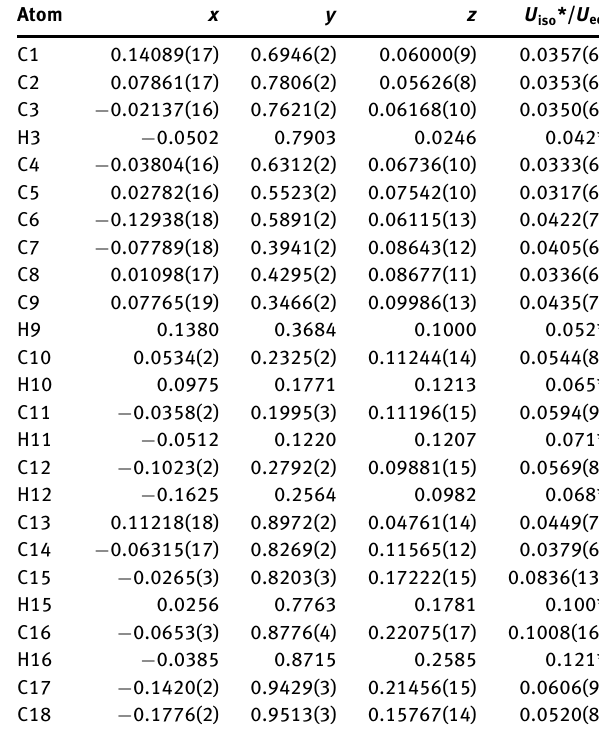
Table 2: Fractional atomic coordinates and isotropic or